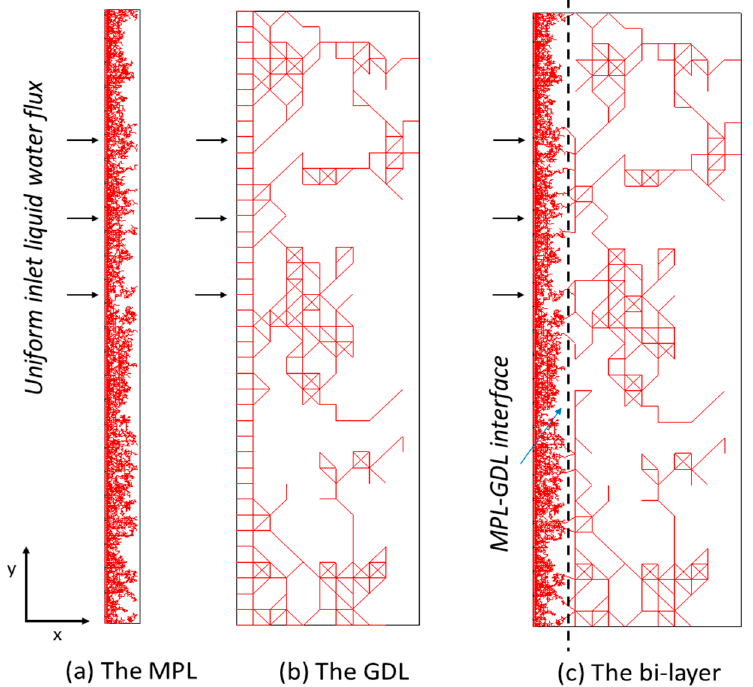
Figure 3. Liquid water pathways (denoted by read lines) in the MPL ( a ); in the GDL ( b ); and in the bi-layer ( c ) using the quasi-static pore-network modeling. The white areas denote the uninvaded pore spaces. The boundary condition of uniform liquid water flux at the inlet was assumed.